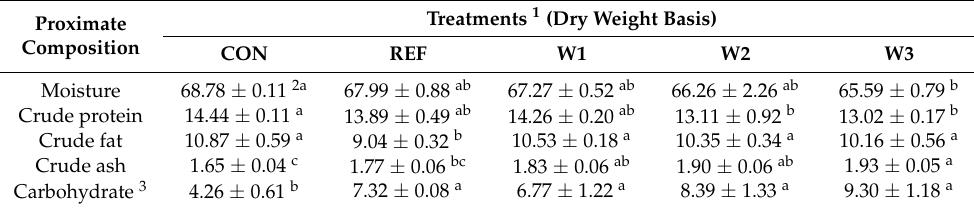
Table 4. Proximate composition of watermelon radish